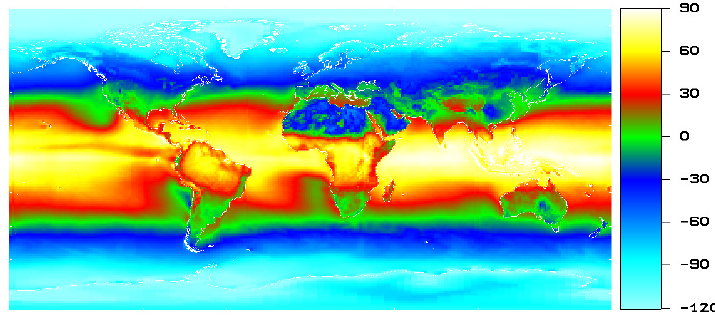
Figure 2. The 10-year mean CERES Energy Balanced And Filled (EBAF) Net Incoming Flux.